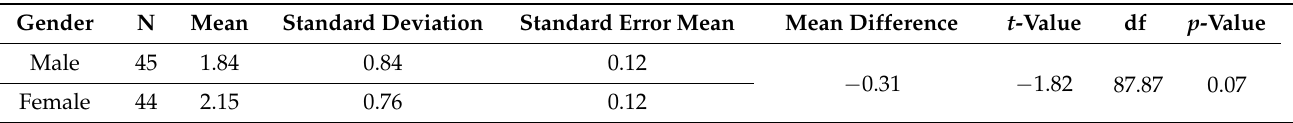
Table 5. Gender disparities between all groups using independent t